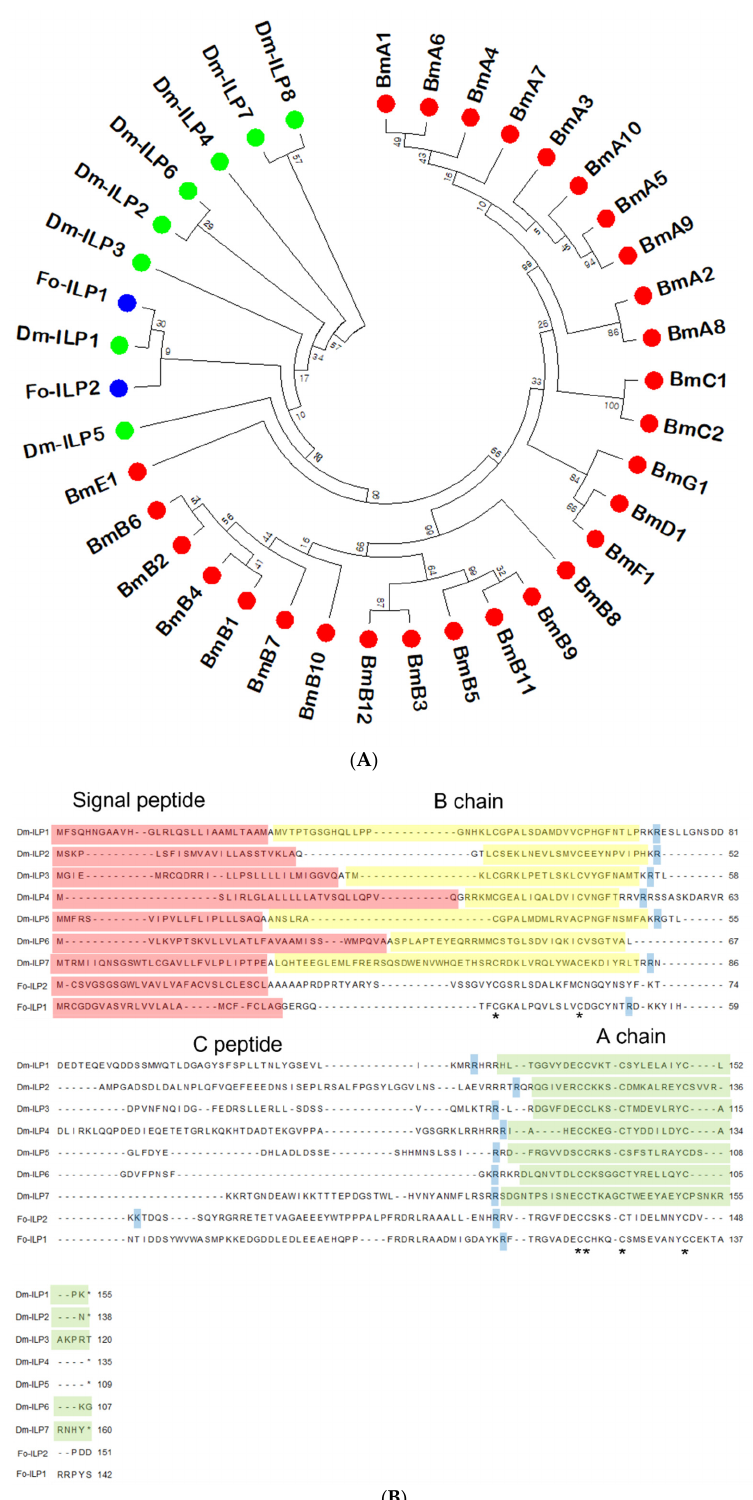
Figure 1. Two insulin-like peptides (ILPs; Fo-ILP1 and Fo-ILP2) of Frankliniella occidentalis . ( A ) Phylogenetic analysis of the two ILPs with the eight ILPs of Drosophila melanogaster (DmILP1~Dm-ILP8) and 28 ILPs of Bombyx mori (BmA1~BmA10, BmB1~Bm12, BmC1, BmC2, BmD1, BmE1, BmF1, and BmG1). The tree was generated by the neighbor-joining method using MEGA 6.0. Bootstrapped values were obtained with 1000 repetitions to support branching and clustering. Amino acid sequences were retrieved from GenBank, and the accession numbers of the genes are shown in Table S2. ( B ) Domain analyses of Fo-ILP1 and Fo-ILP2 compared to the known domains of Dm-ILPs [13]. ‘*’ indicates conserved cysteine residues at the B chain (marked with yellow squares) and the A chain (marked with green squares). Putative proteolytic cleavage sites are marked with blue squares. Signal peptides (marked with red squares) were predicted using the SignalP 5.0 server (https://services.healthtech.dtu.dk/service.SignalP-5.0/ (accessed on 31 December 2022)). Putative cleavage sites were predicted using the Neuroproteomics and Neurometabolomics Center on Cell– Cell Signaling (http://stagbeetle.animal.uiuc.edu/cgi-bin/neuropred.py (accessed on 31 December 2022)). The two ILP genes were expressed at all developmental stages, from larvae to adults (Figure 2A). With the exception of the prepupal and pupal stages, the ILP genes were expressed at relatively stable levels at the larval and adult stages. In investigating the low level of ILP expression during the nonfeeding stages, the larvae (Figure 2B) and adults (Figure 2C) were subjected to starvation. The starvation treatment significantly ( p < 0.05) suppressed the gene expressions of the ILP genes.